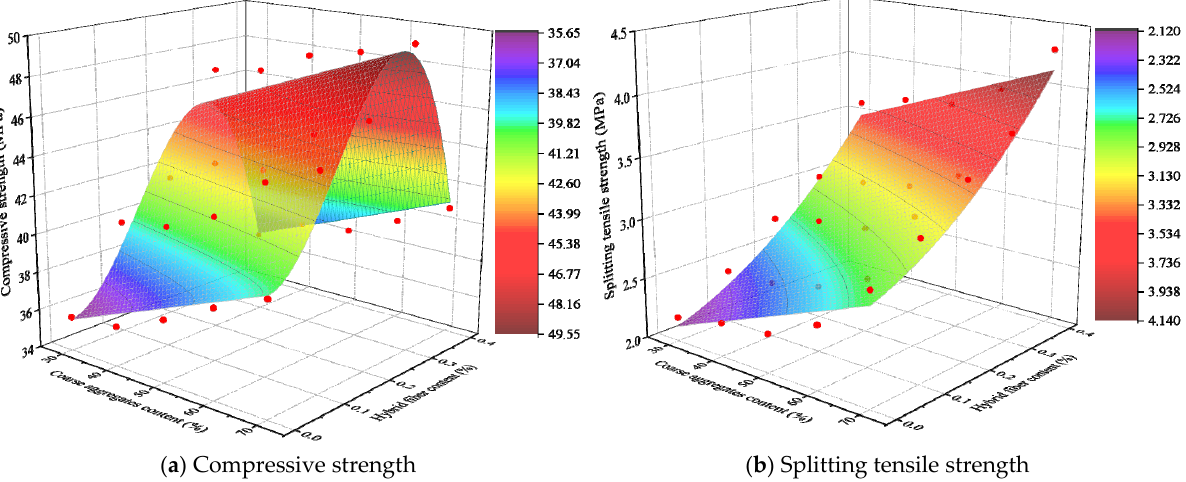
Figure 31. Simulated strength values of hybrid fiber-reinforced LHPCC with different coarse aggre- gate contents.